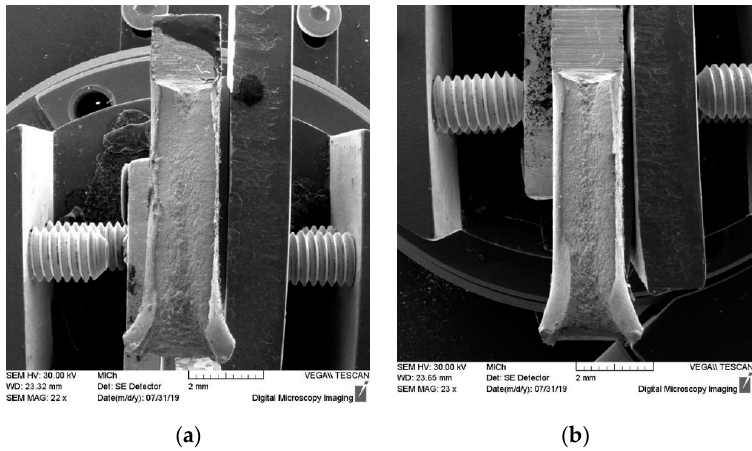
Figure 13. SEM images of the whole fracture surface after the Charpy pendulum impact test with different cooling times t 8/5 : ( a ) sample 7s; ( b ) sample 17s.